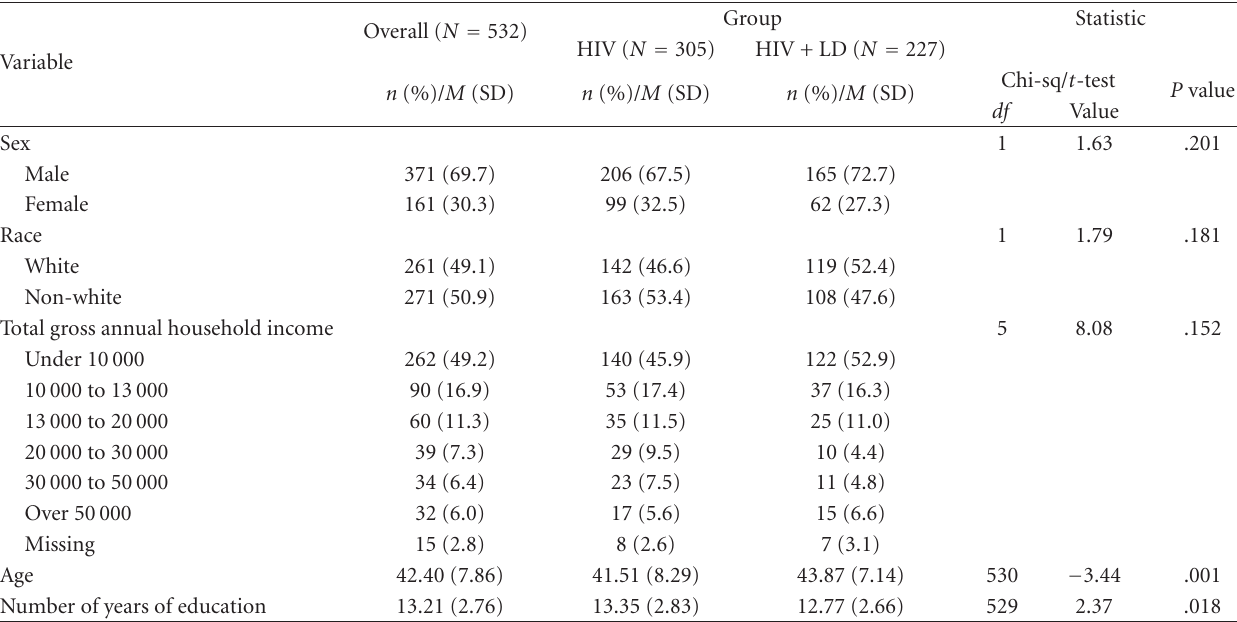
Table 1: Characteristics of demographics in HIV and HIV + LD groups.